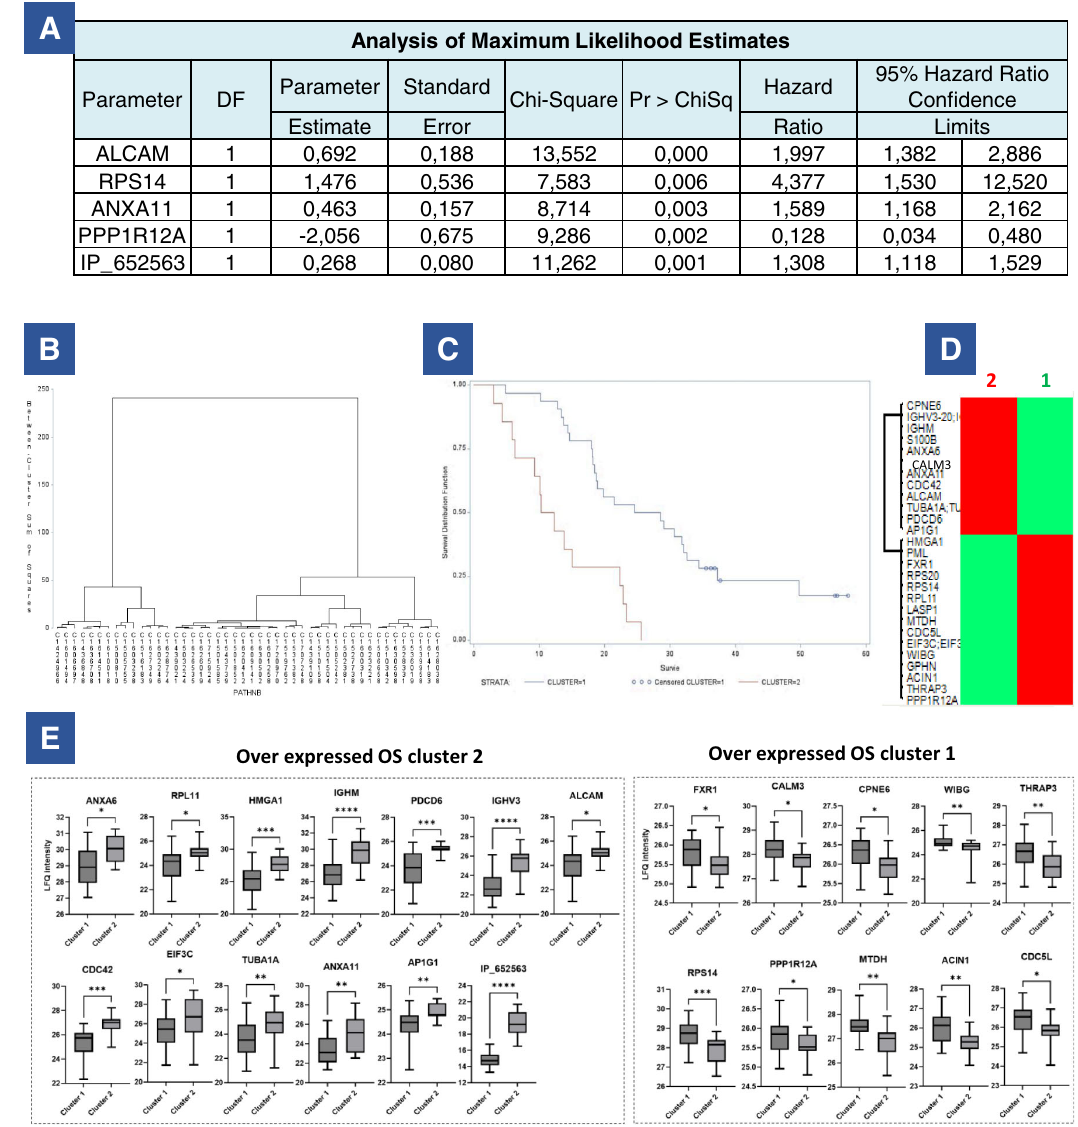
Fig. 3 | Proteomic and survival analysis. A , B Analysis of maximum likelihood estimatesof the fi ve proteins signi fi cantlycorrelated with survival(ANXA11, RPS14, ALCAM, PPP1R12A, and AltProt IP_652563) identi fi ed after a step-by-step analysis and bootstrap procedure and B. patient clustering based on these proteins . C Overall survival of the 46 patients according to the expression of the fi ve prog- nostic markers. Two clusters of patients were identi fi ed with a clear difference in their survival. Cluster 1 has longer survival than cluster 2. D Heatmap of the 28 proteinssigni fi cantintheCoxmodel( P <0.01)betweenthetwogroupsofpatients de fi ned by their OS (left). E Boxplots of the 28 prognosis proteins signi fi cant after applying the Cox model. Their LFQ values were compared between patients of